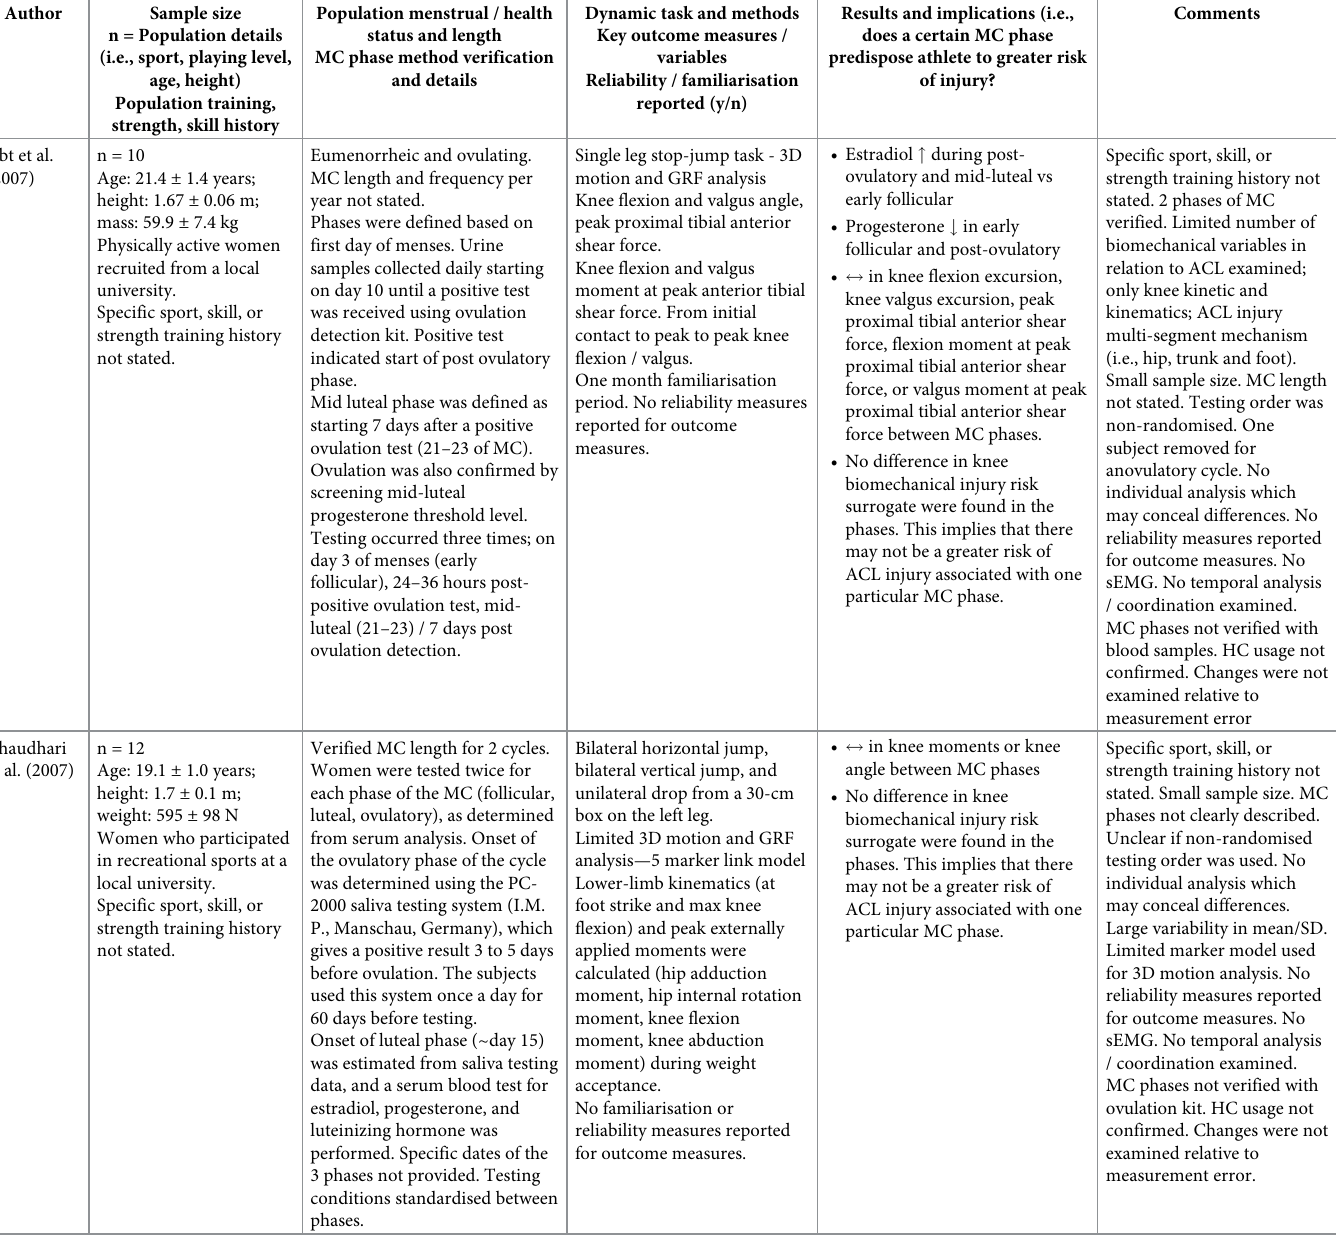
Table 4. Summary of literature that has investigated the effects of MC phase on neuromuscular and biomechanical non-contact ACL injury risk